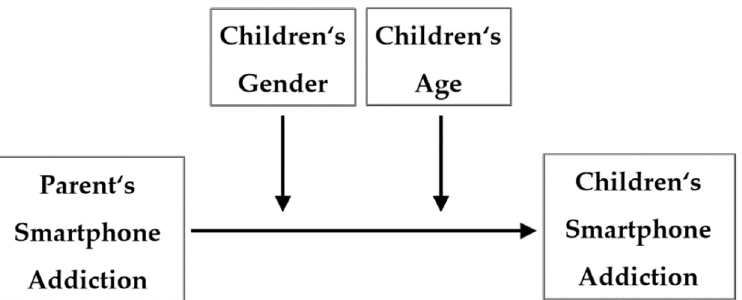
Figure 1. Research Figure 1. Research model.